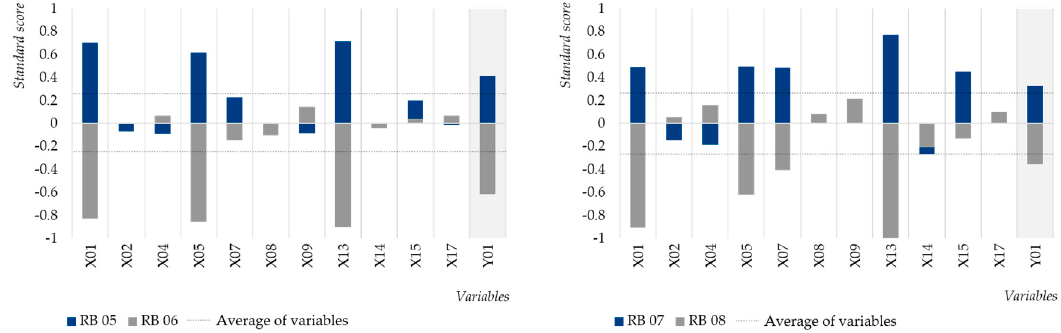
Figure 4. Cluster profile based on variables ( left : method 3, right : method 4).